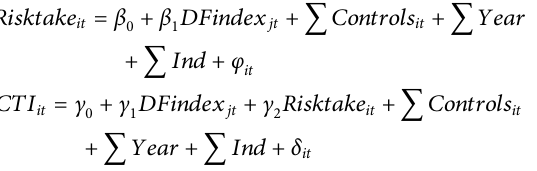
TABLE 4 | Estimations of the risk-taking